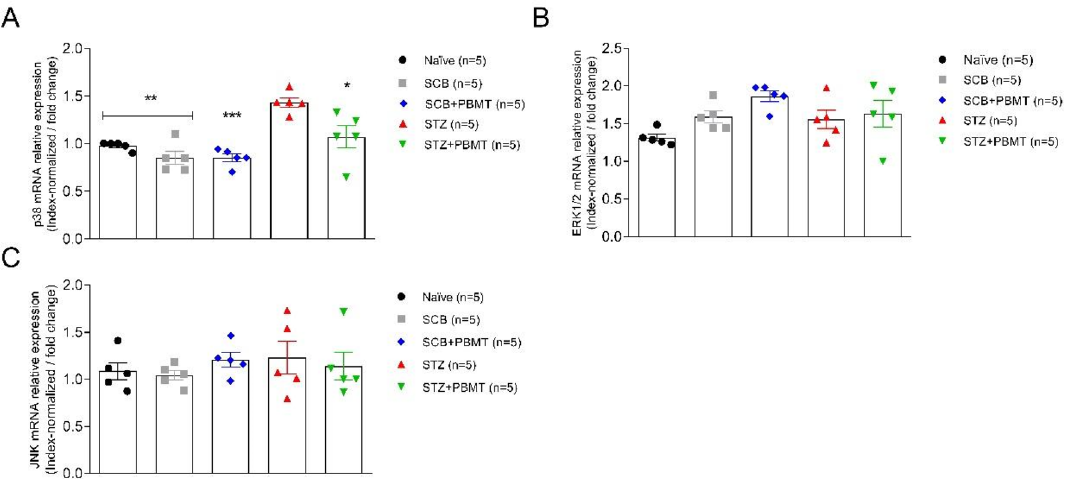
Figure 4. Quantitative expression of MAPK mRNA. Gene expression values of p38 ( A ), ERK1/2 ( B ), and JNK ( C ) were index-normalized by a pool of endogenous controls (Arfgef1 and Serpinb6) expression. PBMT decreased the p38 mRNA expression in hyperalgesic rats (STZ + PBMT group). Hyperglycemia increased p38 mRNA expression, but not ERK1/2 and JNK in DRG associated with hyperalgesia. Data are expressed as mean ± S.E.M.; symbols (*), (**), and (***) mean p < 0.05, p < 0.01, and p < 0.001 (respectively) in the comparisons between STZ (red symbols) and the other groups (Naïve, black symbols; SCB, gray symbols; SCB + PBMT, blue symbols; STZ + PBMT, green symbols); unpaired Student t-